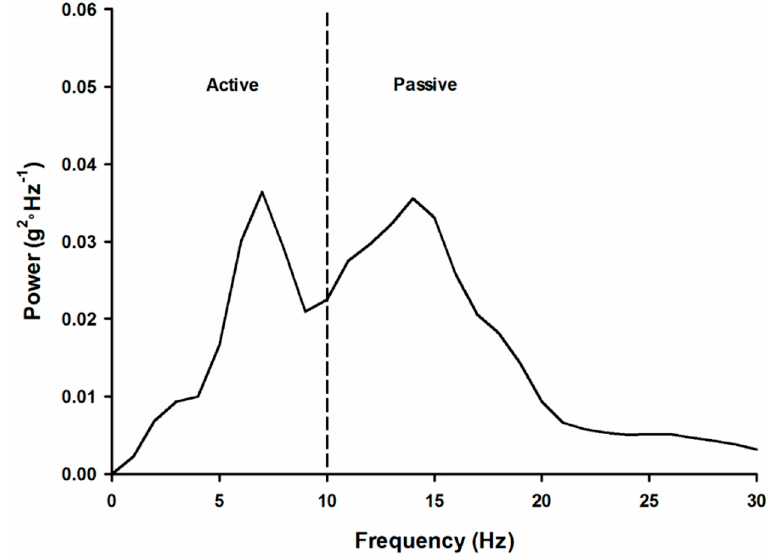
Figure 3. Tibial acceleration profile in the frequency domain.